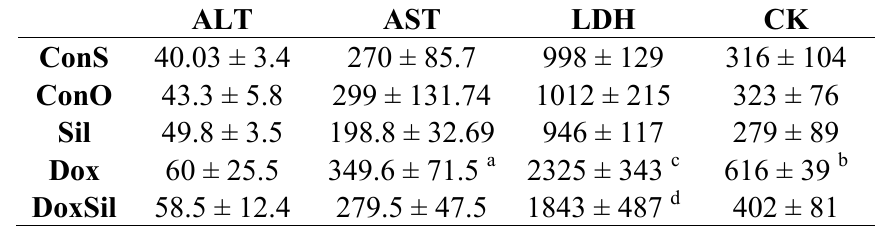
Table 4. Serum enzymatic findings (U/L), in rats treated with saline, olive oil, silymarin, doxorubicin and combination of silymarin and